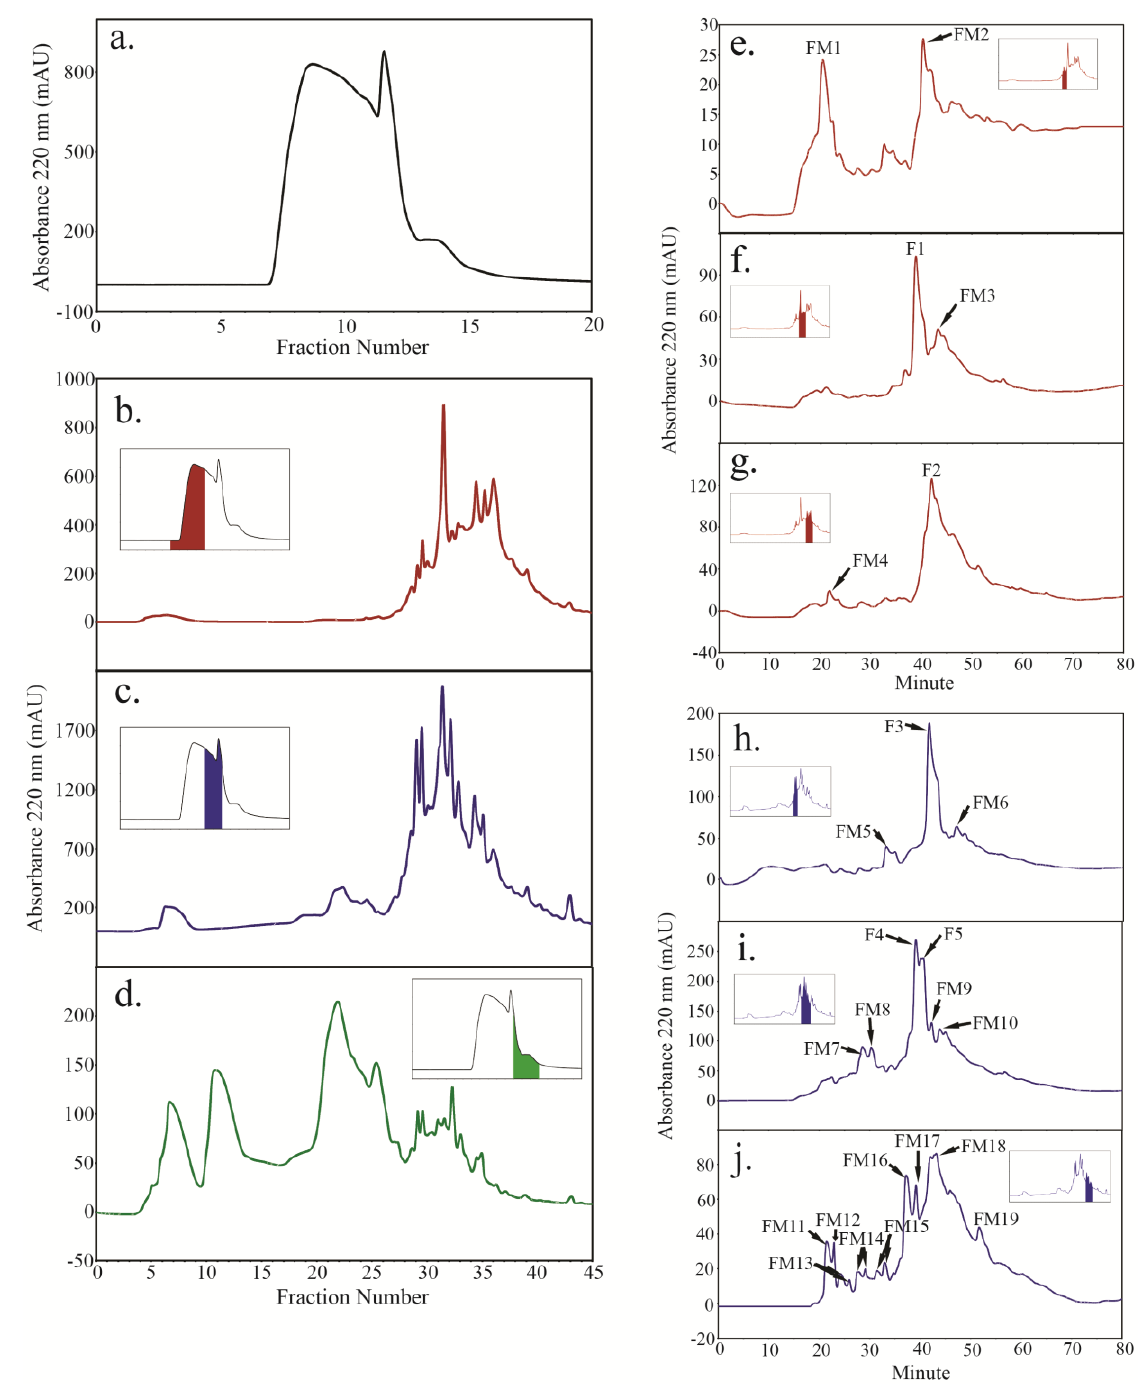
Figure 3. Peptides were isolated from trypsin digested ANP4 HFI using a combination of size exclusion chromatography (SEC) ( a ); strong cation exchange chromatography (SCX) ( b – d ) and reverse phase chromatography ( e – j ); also summarized in Figure 1. Color-coded inserts in panels ( b ) to ( d ) identify the SEC fractions taken in turn for further fractionation by SCX chromatography. Color-coded inserts in panels ( e ) to ( j ) identify the SCX fractions taken in turn for further peptide mapping by reverse phase chromatography. SCX fractions in ( d ) failed to yield any peptide peaks on further fractionation by reverse-phase HPLC. The major peptide peaks (A220 > 100) from the ANP4 HFI are labeled with “F” while minor peptides are labeled as